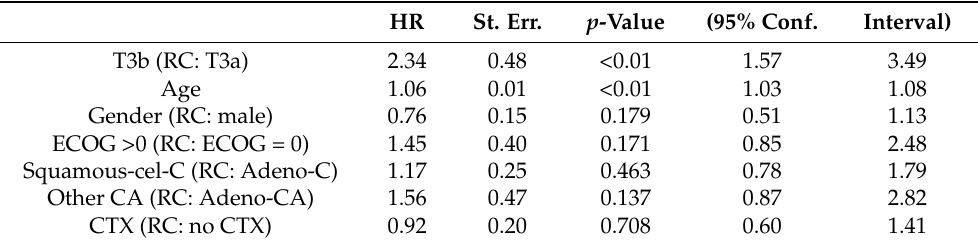
Table 5. Cox regression analysis of patients with pT3N0 NSCLC. Patients with adjuvant radio– chemotherapy/radiotherapy are